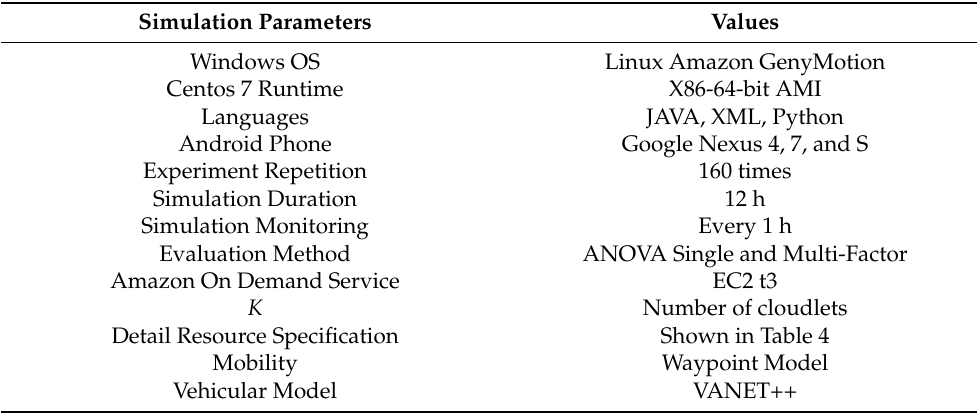
Table 2. System and Vehicular Mobility Simulation Parameters.